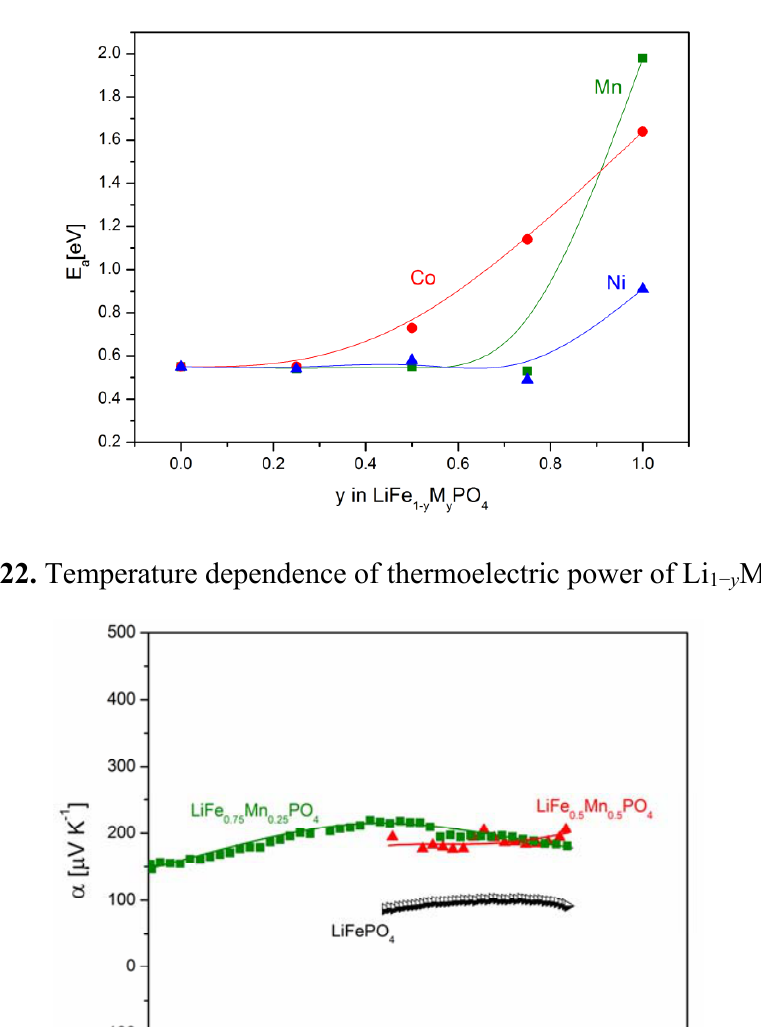
Figure 21. Chemical composition dependence of activation energy of electrical